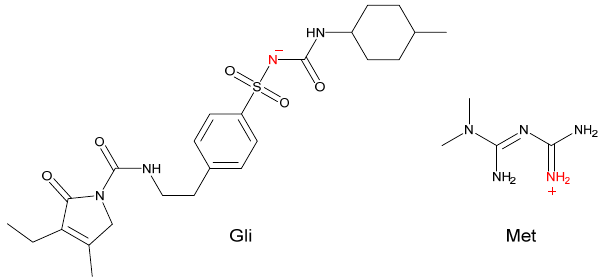
Figure 6. Chemical structures of the Gli and Met with basic and acidic sites highlighted, respectively.